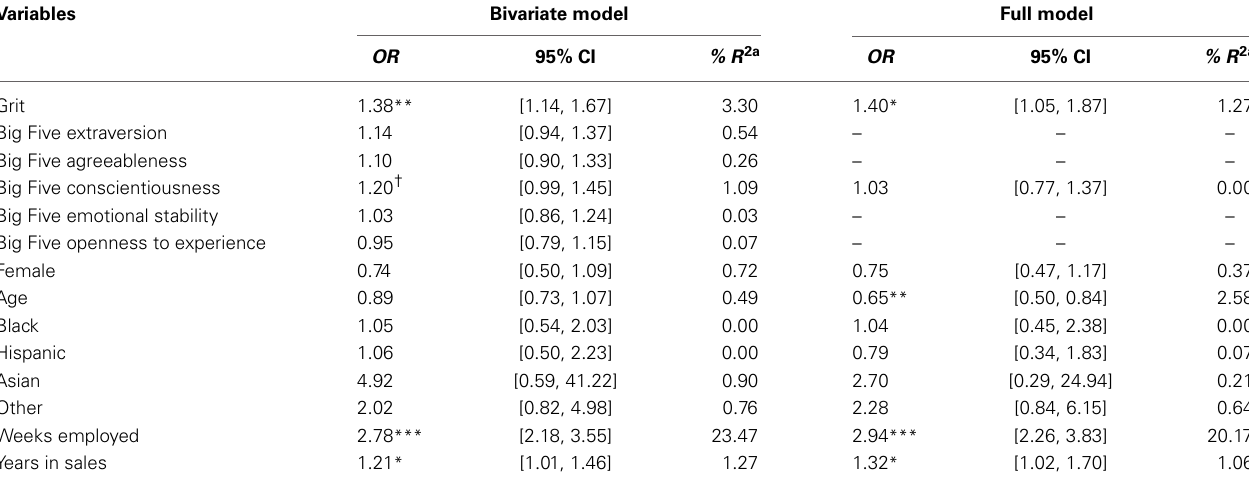
Table 2B | Bivariate and full logistic regressions predicting sales employee retention (Study 2).